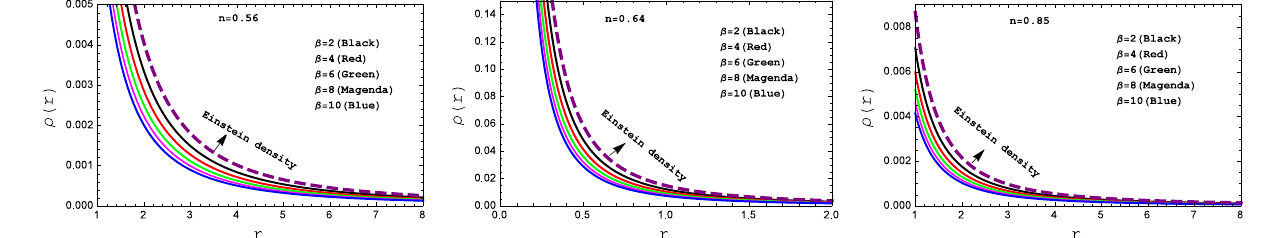
Figure 1. Behavior of the “energy density” with respect to the radial coordinate “ r ” for the compact stars PSR J1614-2230 ( left panel ), Vela X-1 ( middle panel ) and 4U 1538-52 ( right panel ) corresponding to the numerical value of constants A and B from Table 2 and for different values of β